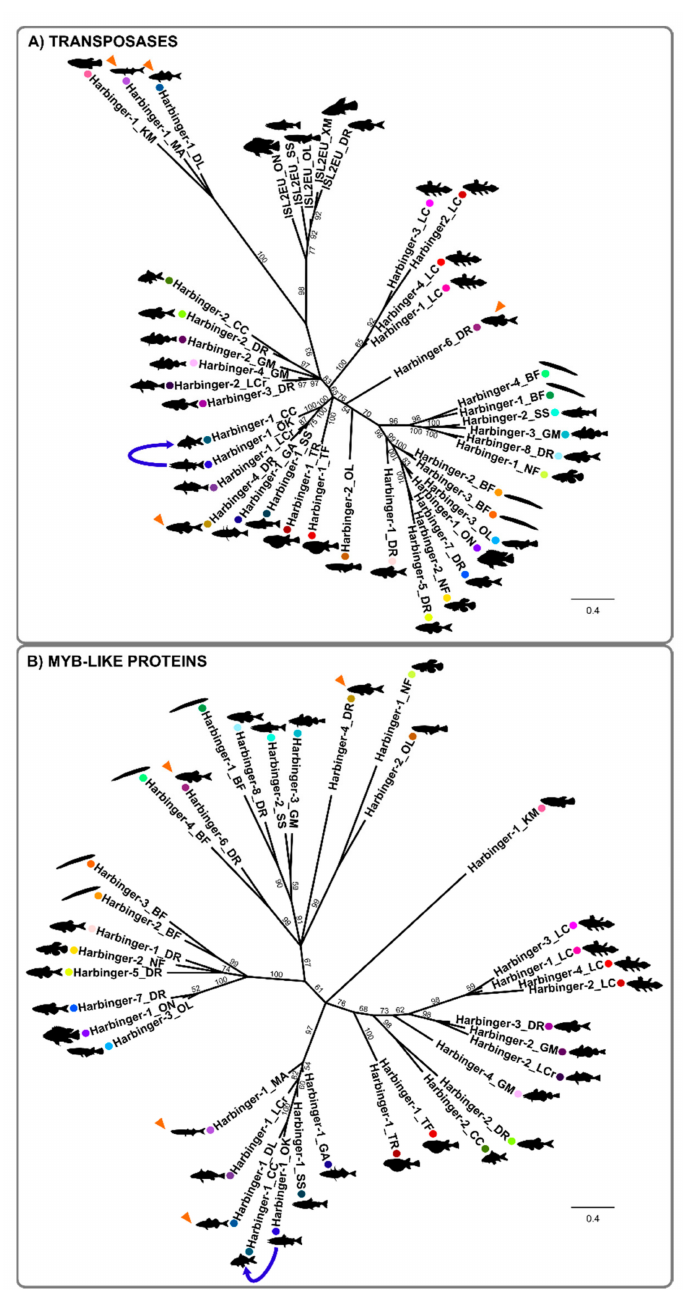
Figure 4. Phylogenetic relationships between Harbinger and ISL2EU transposases ( A ) and Myb -like proteins ( B ) from different fish species. The tree was constructed using the Bayesian method; posterior probability values are indicated [35]. Colored dots indicate the correspondence of the transposases and Myb -like proteins from a same Harbinger element. The orange arrowheads indicate non-congruent elements between the ( A , B ) phylogenies (see Figure 5). The blue arrow indicates a probable case of horizontal transfer. BF: Branchiostoma floridae amphioxus, CC: Cyprinus carpio carp, DL: Dicentrarchus labrax bass, DR: Danio rerio zebrafish, GA: Gasterosteus aculeatus stickleback, GM: Gadus morhua cod, KM: Kryptolebias marmoratus killifish, LC: Latimeria chalumnae coelacanth, LCr: Larimichthys crocea croaker, MA: Monopterus albus eel, NF: Nothobranchius furzeri killifish, OK: Oncorhynchus kisutch silver salmon, OL: Oryzias latipes medaka, ON: Oreochromis niloticus tilapia, SS: Salmo salar salmon, TF: Takifugu flavidus fugu, TR: Takifugu rubripes fugu, XM: Xiphophorus maculatus